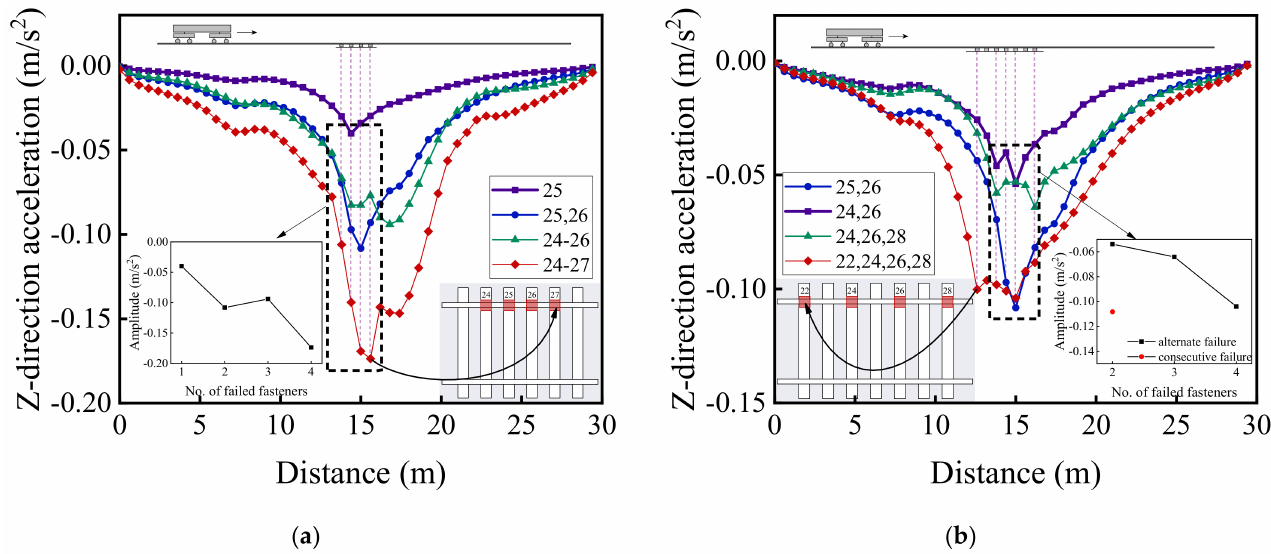
Figure 24. The longitudinal variations of vertical acceleration responses of subgrade surface (under No. 1 to No. 50 rail node) at the side with ( a ) single-side consecutively failed fasteners and ( b ) single-side alternately failed